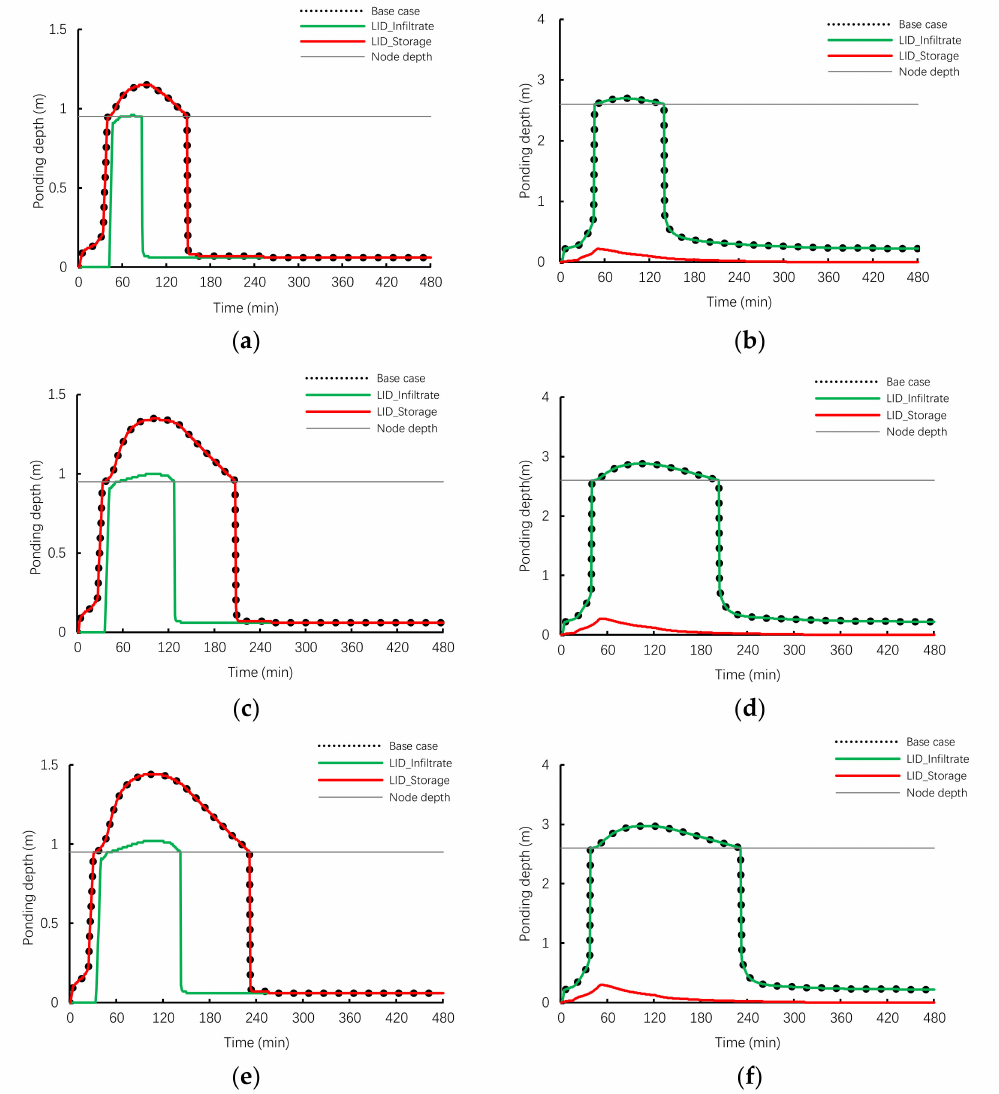
Figure 6. Ponding time of various LID scenarios when rainfall duration is 120 min: ( a ) When return period is 1a, ponding time at node 47; ( b ) When return period is 1a, ponding time at node 52; ( c ) When return period is 3a, ponding time at node 47; ( d ) When return period is 3a, ponding time at node 52; ( e ) When return period is 5a, ponding time at node 47; ( f ) When return period is 5a, ponding time at node